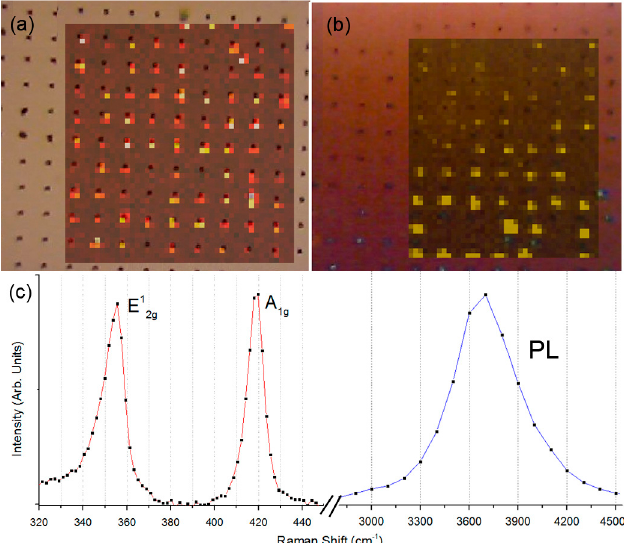
Figure 8. ( a ) Raman Map, integrated on the A 1g mode at 410 cm − 1 ; ( b ) PL map—excitation at 532 nm—emission integrated between 3000 and 4000 cm − 1 ; ( c ) Example of collected spectrum.